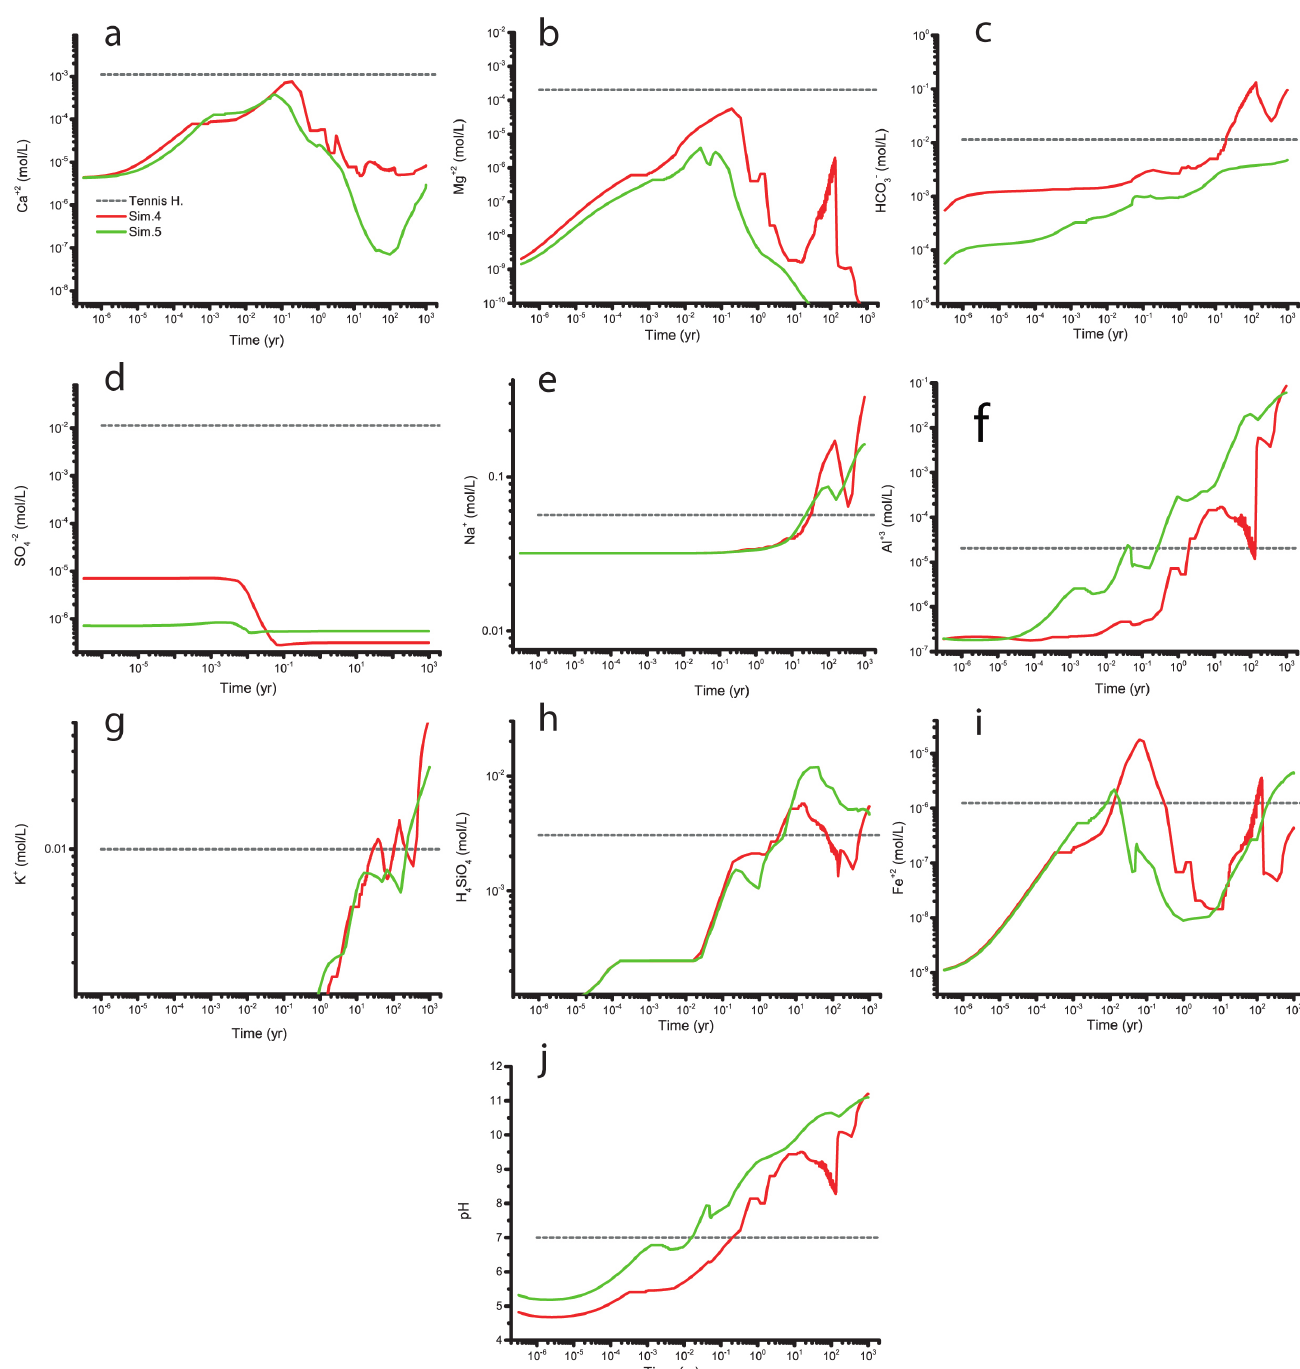
Figure 11. Simulations 4 and 5: an aqueous species evolution over time at 85 ◦ C and PCO 2 =0.12 bar (red lines) and PCO 2 = 0.012 bar (green lines). Simulation results were compared to the geochemical analysis of the Tennis hotel (Table 3). ( a ) Ca +2 ; ( b ) Mg +2 ; ( c ) HCO 3- ; ( d ) SO 4 − 2 ; ( e ) Na + ( f ) Al +3 ; ( g ) K + ;( h ) H 4 SiO 4 ; ( i ) Fe +2 ; ( j ) pH. Simulated initial water composition was set as a NaCl (0.033 M) equivalent water, with neutral pH and initial concentrations of 1 × 10 − 9 mol/L for all the other ions and aqueous